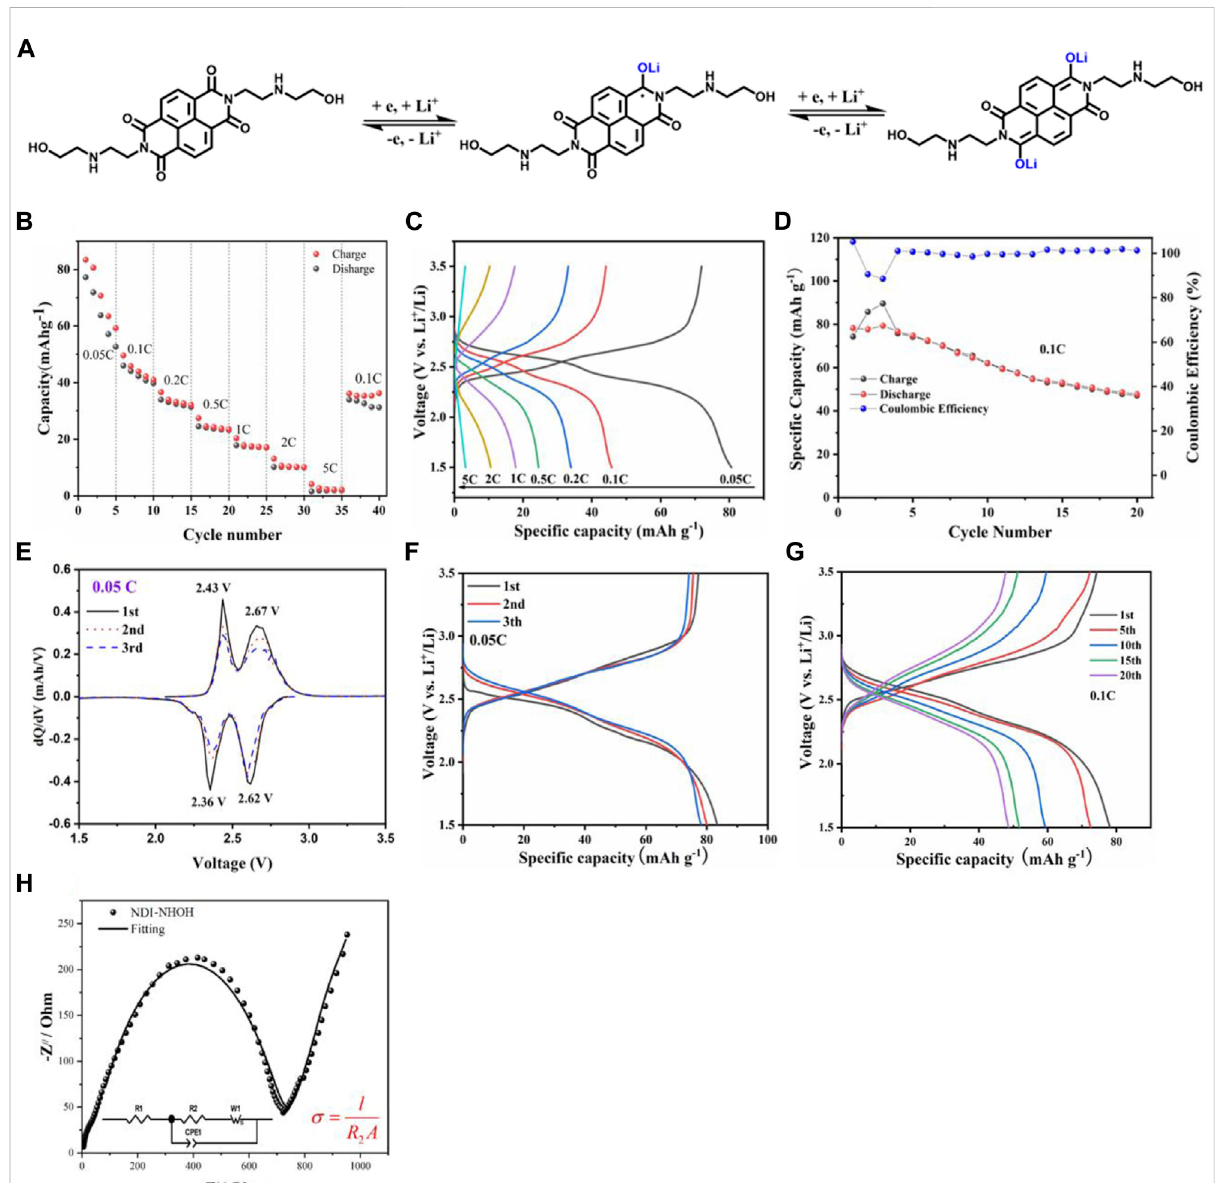
FIGURE 4 (A) TheworkmechanismofNDI-NHOHelectrode; (B) rateperformance, (C) charge-dischargepro fi les,and (D) charge-dischargecyclecurves; (E) differential capacities (dQ/dV) vs. voltage plots for the initial charge-discharge curves at 0.05 C of NDI-NHOH electrode, (F) Galvanostatic discharge and charge curves at 0.05 C and (G) Galvanostatic discharge and charge curves at 0.1 C; (H) Nyquist plot from EIS